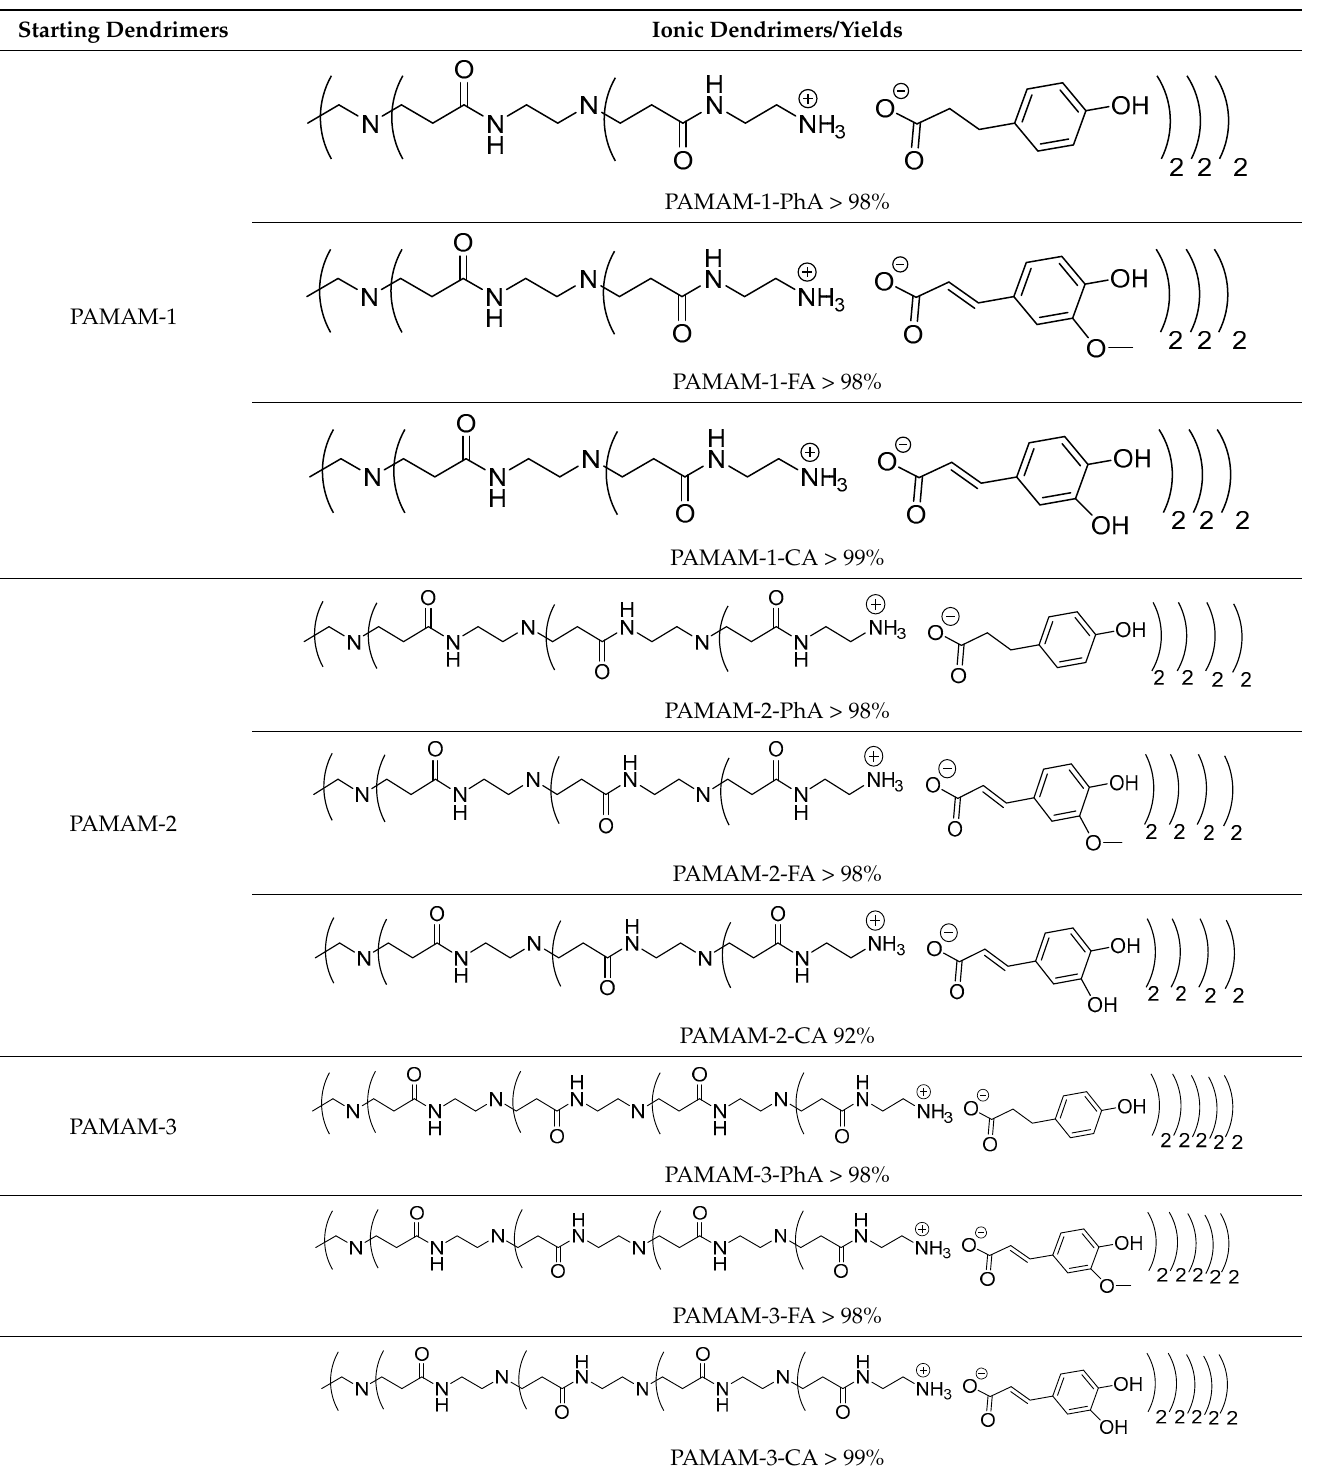
Table 2. Ionic PAMAM-derived dendrimers.